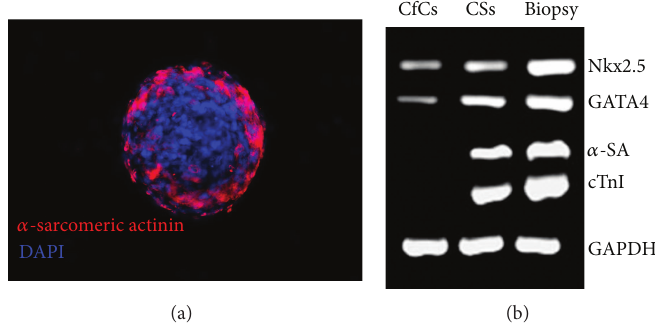
Figure 3: (a) Immunostaining of a human CS showing cells expressing cardiac 𝛼 -sarcomeric actinin (red) in the outer sheet; nuclear staining with DAPI (blue). (b) PCR expression analysis of early and late cardiac genes by CS-forming cells (CfCs), CSs, and human cardiac biopsy tissue. CfCs express lower levels of early genes (Nkx2.5 and GATA4 transcription factors) compared to CSs, but no 𝛼 -sarcomeric actinin (SA) nor cardiac troponin I (cTnI). CSs express high levels of both early and late cardiac